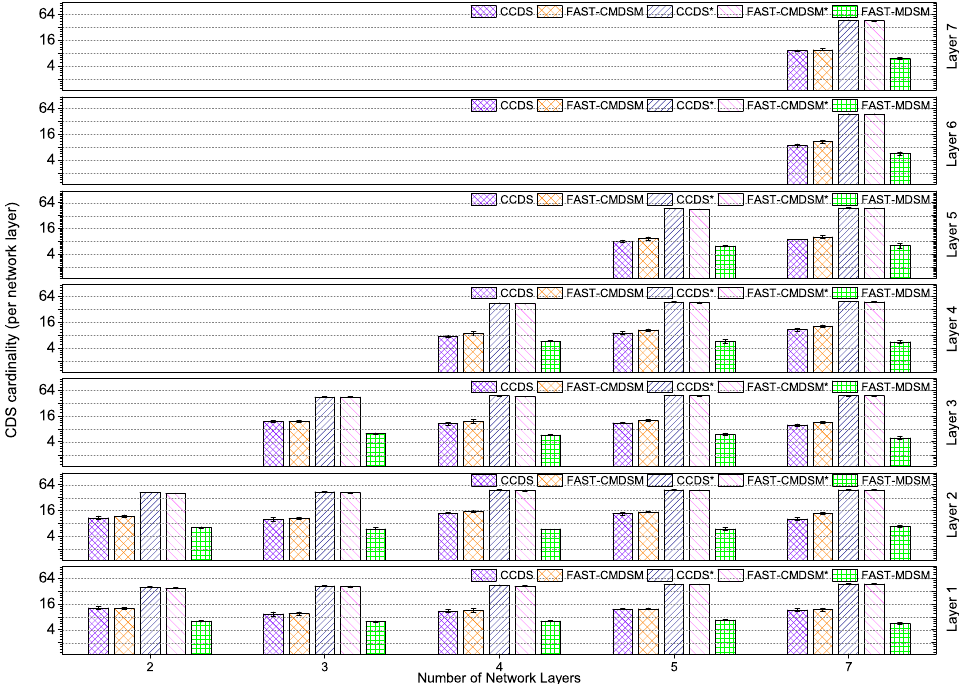
Figure 10. Impact of number of layers (Medium